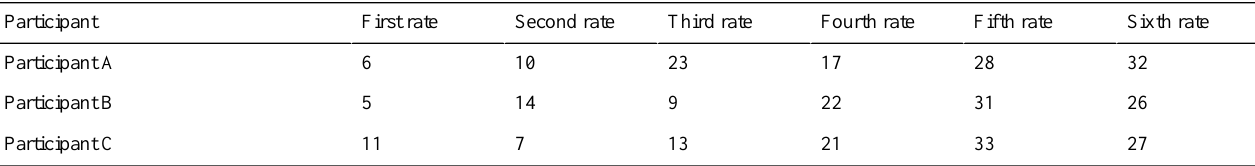
Table 2. Examples of possible sets of metronome rates to be used.